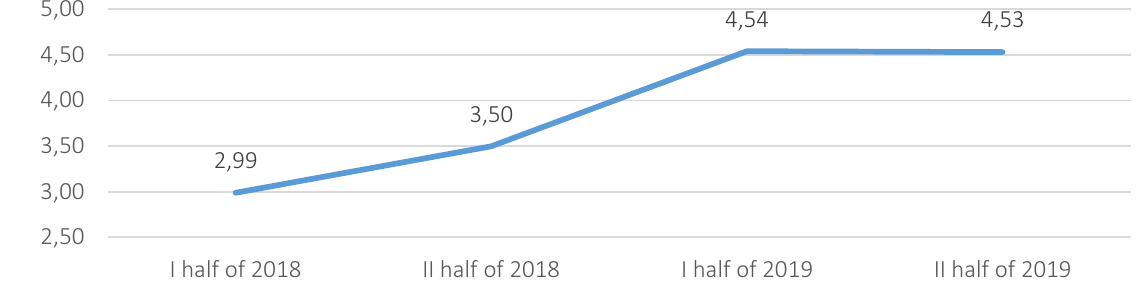
Figure 3. Average cost per click in 2018–2019,